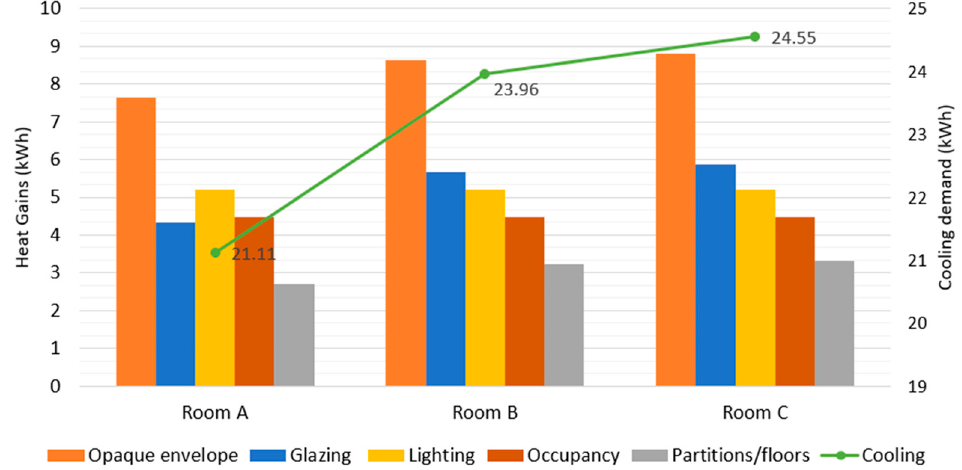
Figure 10. Average heat gains and cooling demand per room.